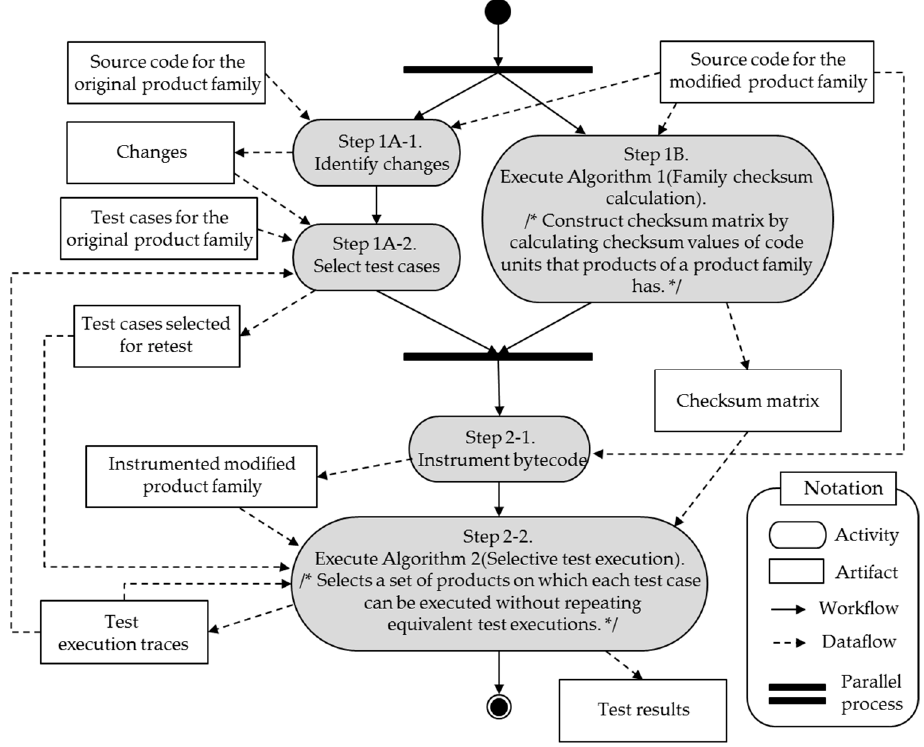
Figure 3. The detailed process of our method.